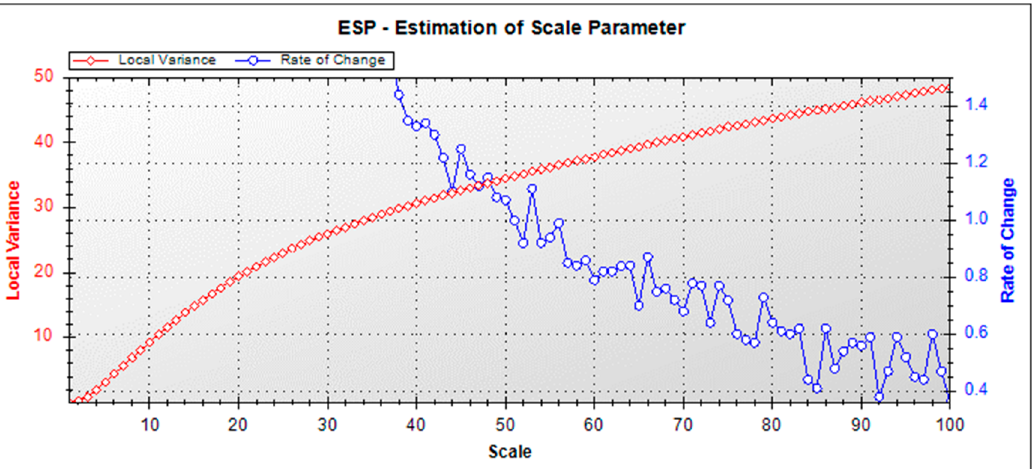
Figure 4. Local variance and rate of change of different values of scale calculated by the ESP tool with a shape of 0.1 and compactness of 0.5. with a shape of 0.1 and compactness of